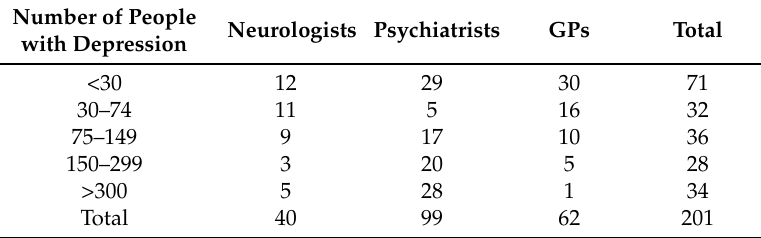
Table 2. Description of the sample with respect to the treatment